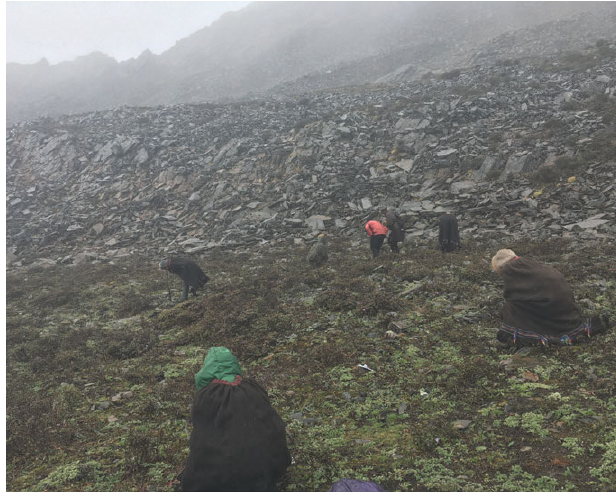
Fig. 4. Foraging: Harvesters looking for stromata of Ophiocordyceps . Photo: Siran